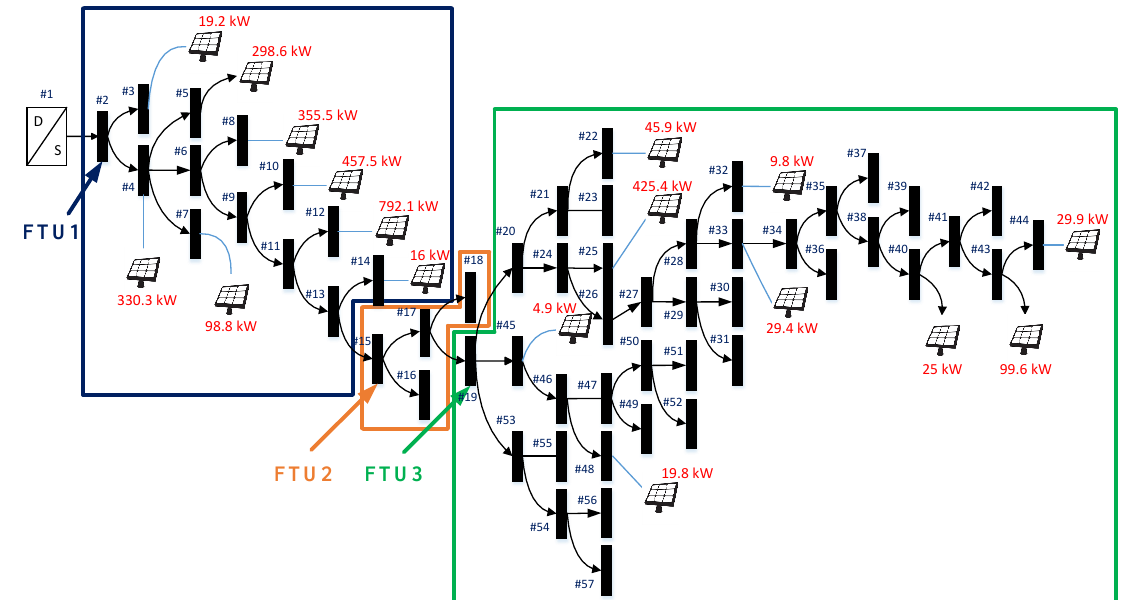
Figure 9. One-line diagram of the practical distribution feeder.